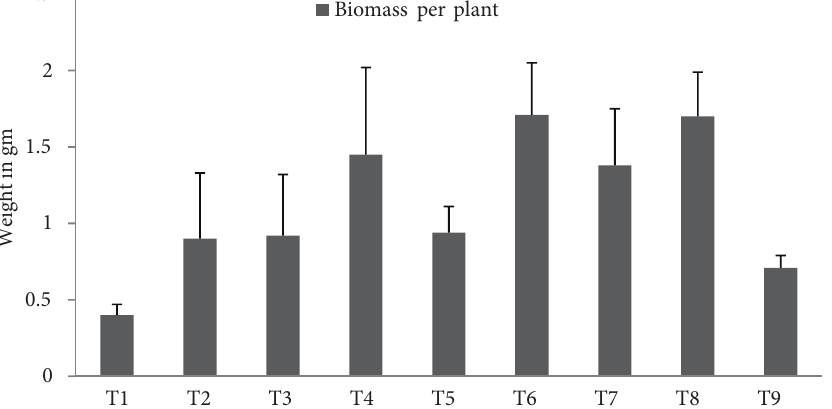
Figure 4. Effect of rhizobacteria on average nodule count per host plant in field